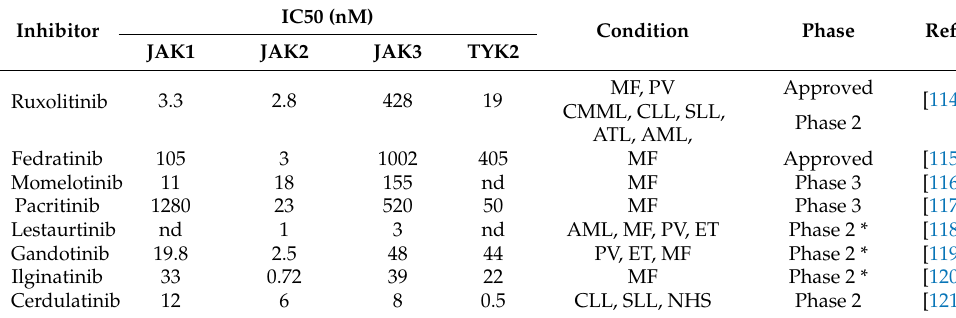
Table 1. Clinical stage JAK inhibitors for